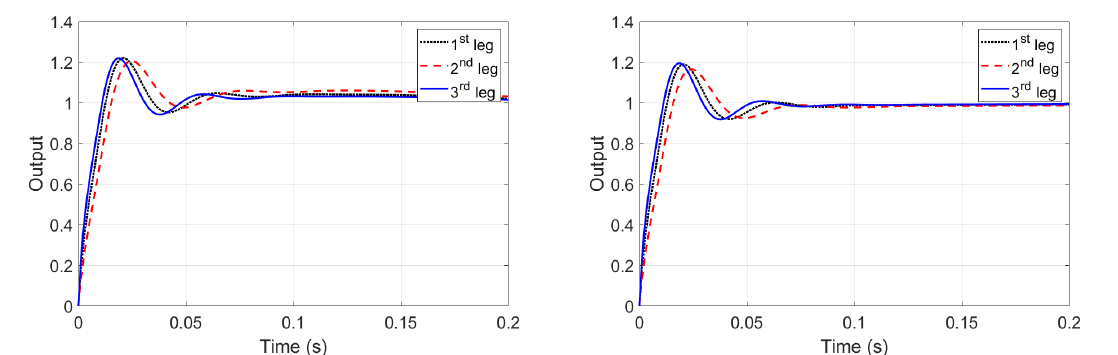
Figure 9. Step responses for the adaptive controller for three legs for the first case, P 1 ( s ) ( left ), and the second case, P 2 ( s ) ( right